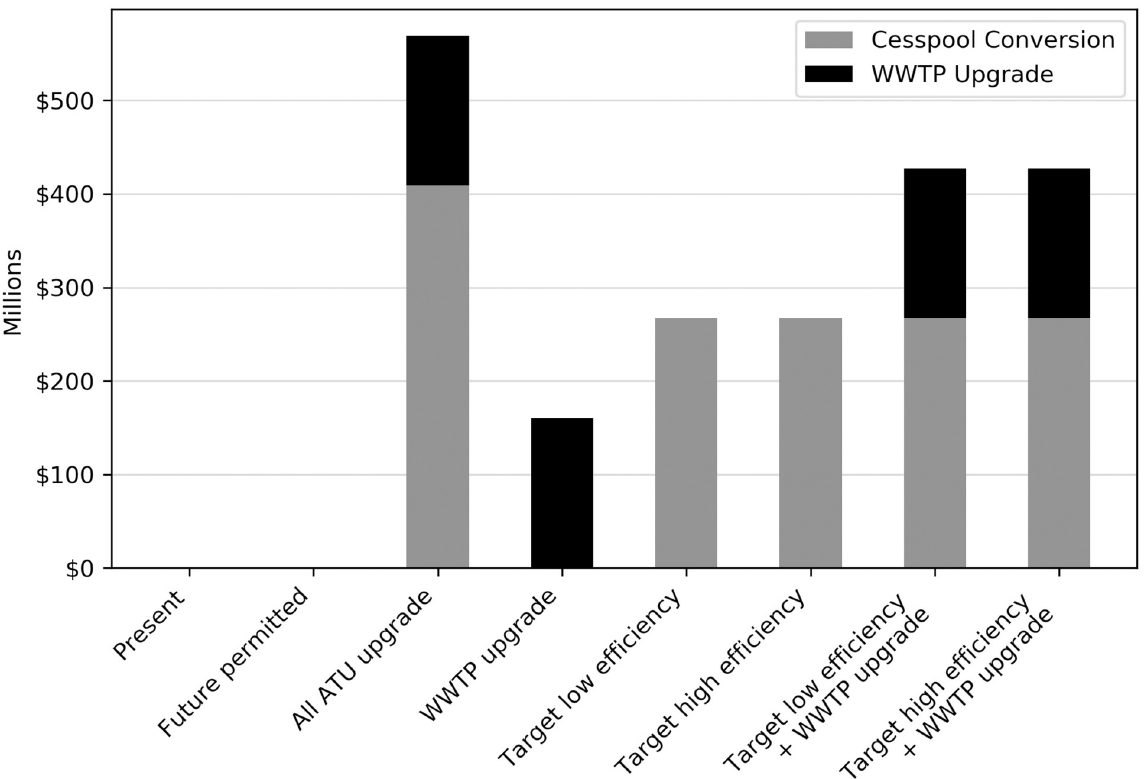
Fig 8. Present value costs of cesspool and WWTP upgrades.